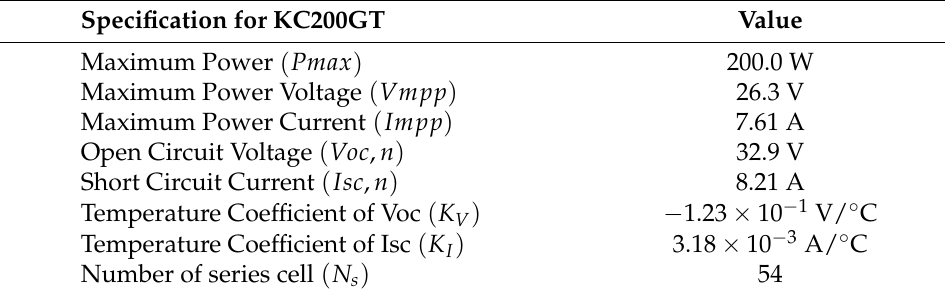
Table 4. Electrical performance at standard test conditions (STC).